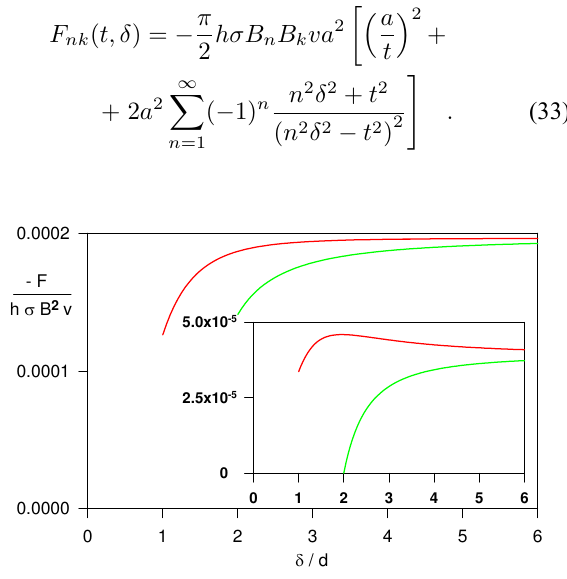
Figure 8: Braking factor − F/hσB 2 v as a function of the ratio δ/d for poles touching each other ( d/a = 2 ): lon- gitudinal (red curve) and transverse (green curve) arrange- ments. At the inset we show the behavior of the similar ratios for the mutual forces F nk ( l = d, δ ) (red curve) and F nk ( t = d, δ ) (green curve) versus δ/d